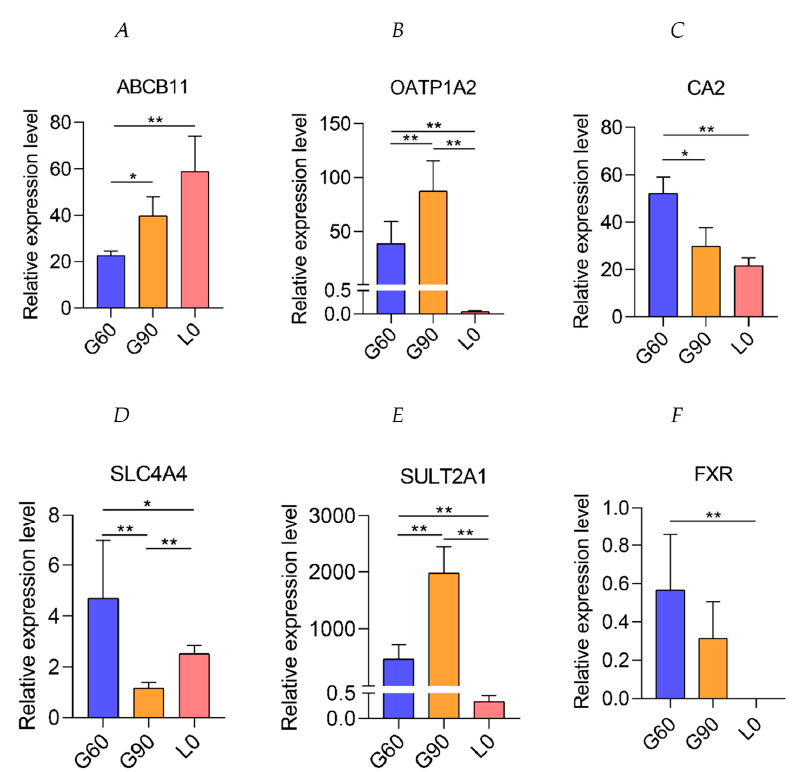
Figure 5. The di ff erentially expressed genes involved in bile secretion at G60, G90, and L0 placentas. ( A ) The relative expression levels of ABCB11 , ( B ) organic anion-transporting polypeptide 1A2 ( OATP1A2) , ( C ) carbonic anhydrase II ( CA2) , ( D ) SLC4A4 , ( E ) hydroxysteroid sulfotransferases ( SULT2A1) , and ( F ) FXR determined by RNA-Seq at G60, G90, and L0. Data are shown as means ± SE, * p < 0.05, ** p < 0.01.